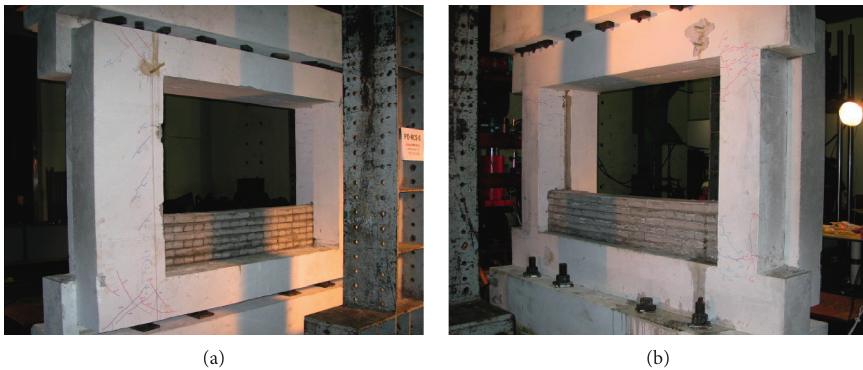
Figure 23: Cracks appeared in the PD-WESRCF specimen during pseudodynamic testing at 400gal after (a) 4.5s with lateral displacement of 19.6mm and force of 489kN, and (b) during the final stage (7s).